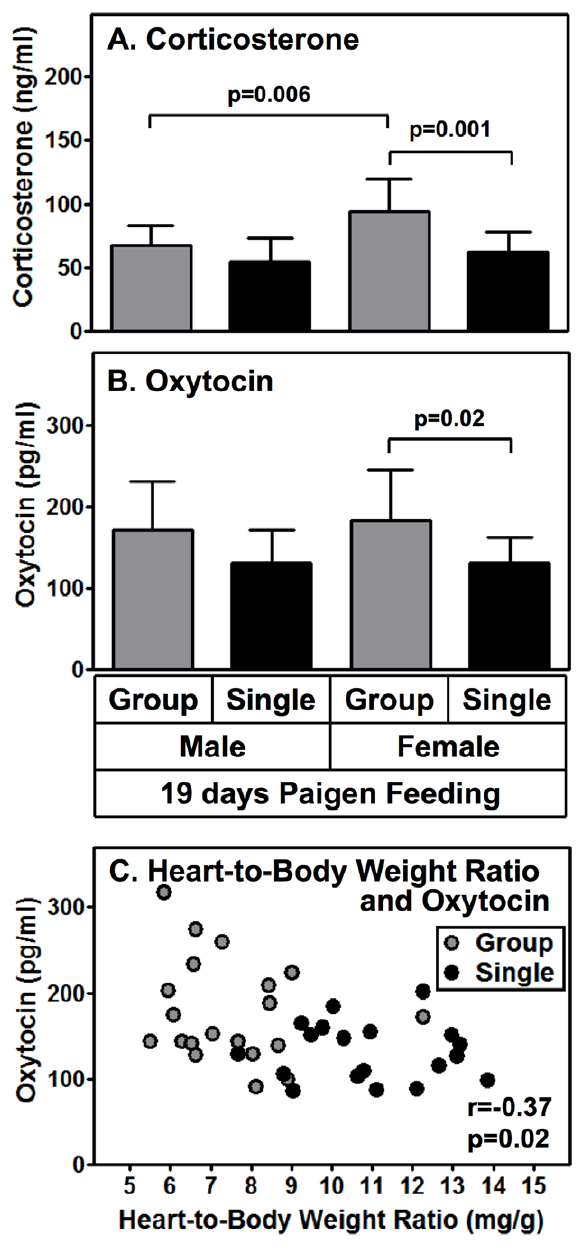
Figure 6. Population density and sex effects on plasma corticosterone and oxytocin in Paigen diet-fed HypoE mice. HypoE mice were housed in mixed genotype groups (HypoE and one or more SRBI + / 2 ApoeR61 h/h littermates per group, 4–5/cage, gray bars) or singly (1/cage, black bars). Beginning at two months of age the animals were switched from a normal chow diet to the Paigen diet. After 19 days of Paigen diet feeding, the mice were weighed, plasma and hearts were harvested, heart weights measured and plasma levels of corticosterone and oxytocin were determined. The values presented are from the HypoE mice only; they do not include the companion (group housing) SR-BI + / 2 ApoeR61 h/h mice. A Plasma corticosterone levels: group housed males, n=11; singly housed males, n=14; group housed females, n=16; singly housed females, n=12. B Plasma oxytocin levels: group housed males, n=8; singly housed males, n=8; group housed females, n=12; singly housed females, n=11. Data are means 6 SD. Statistically significant differences were determined by unpaired t-test. C Correlation of oxytocin levels and heart-to-body weight ratios for all HypoE mice (n=39). Gray and black circles